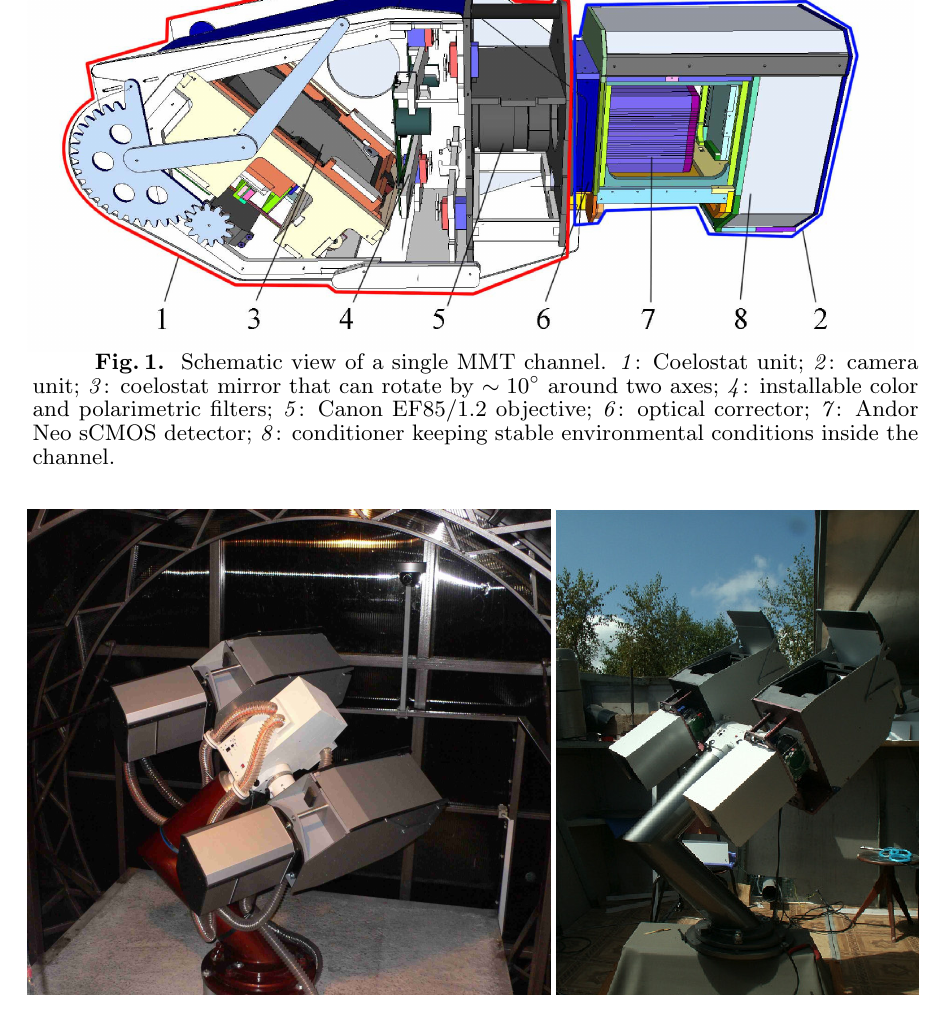
Fig. 2. Two MMT channels installed on a single mount. The complete system consists of five such mounts, carrying nine operative channels and one replacement chan-